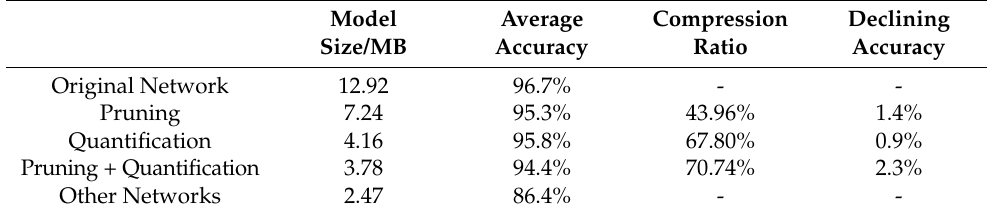
Table 5. Comparison of source number estimation network compression